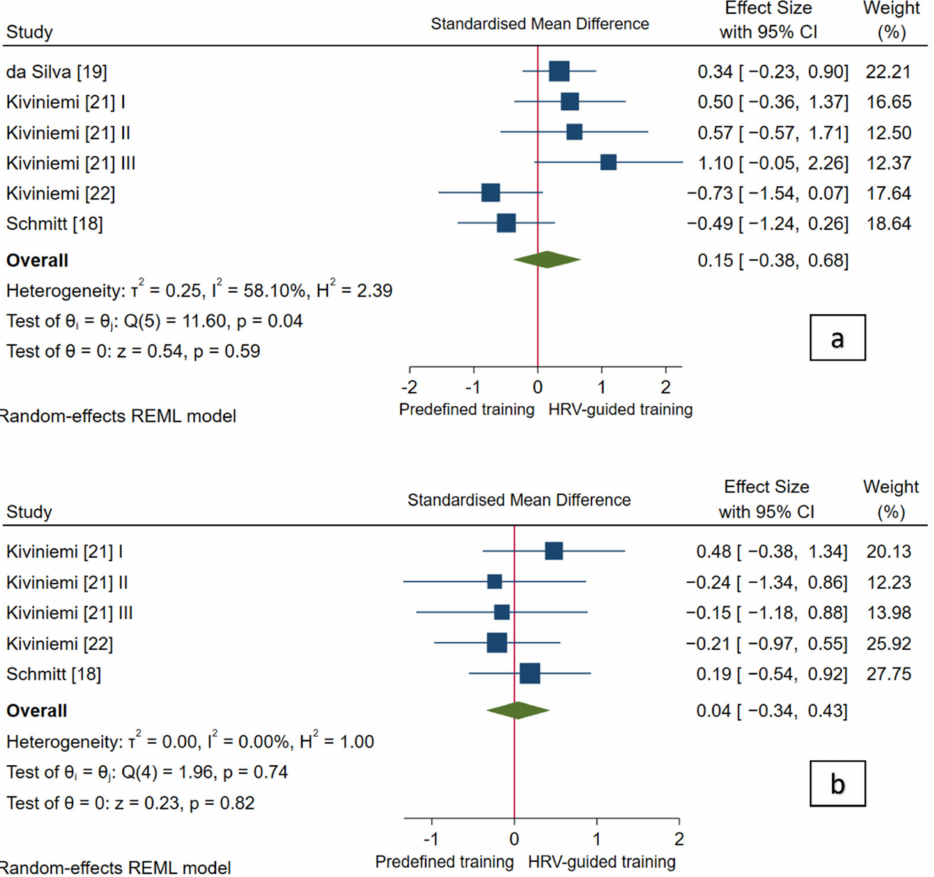
Figure 2. Forest plot of standardized mean difference indices for cardiac-vagal modulation: ( a ) standing vagal-related heart rate variability indices, and ( b ) standing heart rate. I, II, III refer analysis units from the same